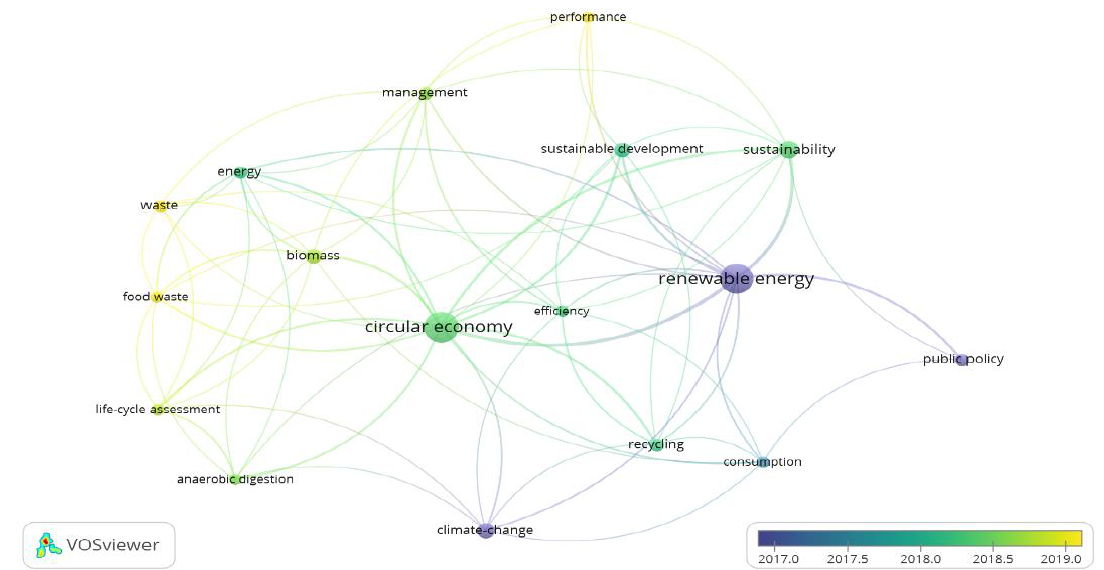
Figure 8. Global evolution of the network of keywords associated with public policies related to renewable energies from the perspective of the CE.